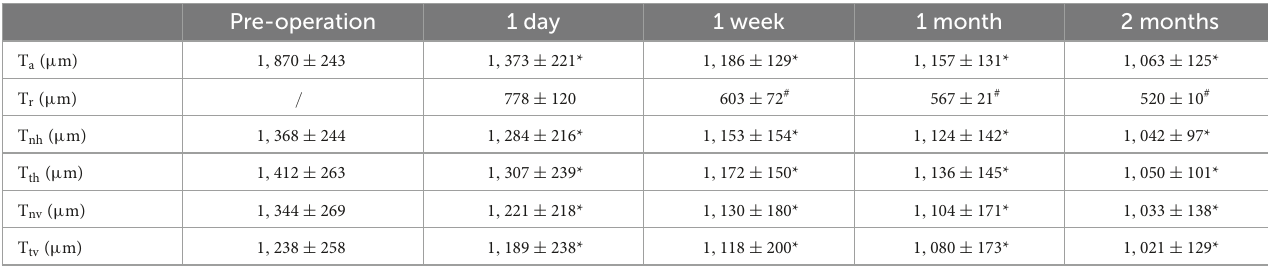
TABLE 1 AS-OCT results preoperatively and 2 months after the first-stage